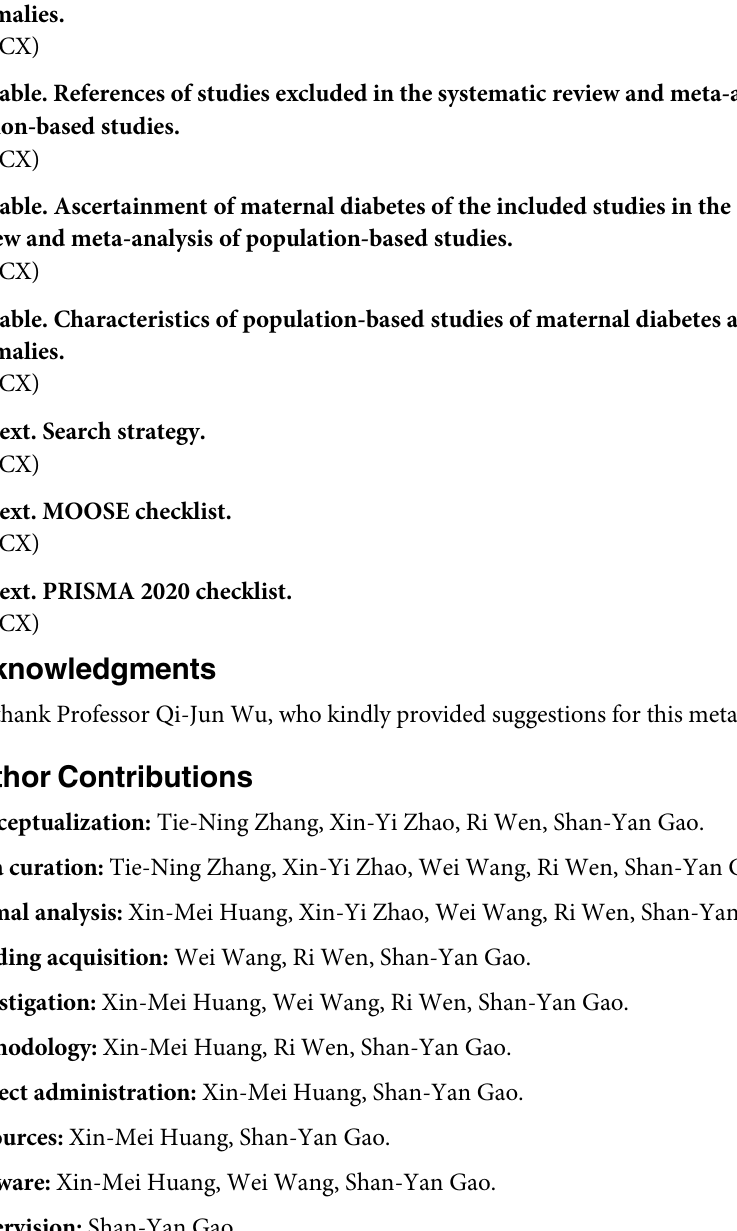
S1 Table. EUROCAT, ICD-10, and ICD-9 codes used to identify and define congenital anomalies. S2 Table. References of studies excluded in the systematic review and meta-analysis of pop- ulation-based studies. S3 Table. Ascertainment of maternal diabetes of the included studies in the systematic review and meta-analysis of population-based studies. S4 Table. Characteristics of population-based studies of maternal diabetes and congenital